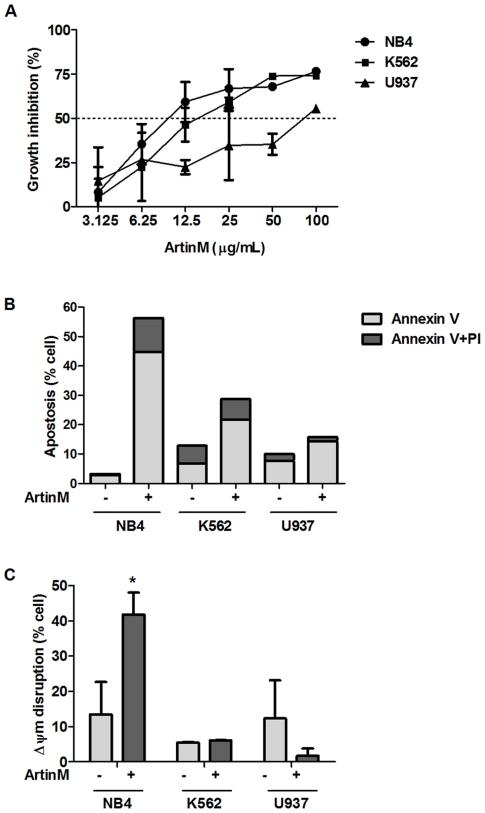
ArtinM inhibits cell growth inhibition and pro-apoptotic effect on NB4 cells.
A) NB4, K562, and U937 cells were cultured for 48 h in the presence or of ArtinM (3.125 to 100 µg/mL). Cell growth was evaluated by MTT assay. The curves show the ArtinM inhibition of cell growth relative to the growth of untreated cells. Each point was obtained from a triplicate assay, and the results shown are representative of 3 independent experiments. The dotted horizontal line indicates the ArtinM concentration necessary for 50% growth inhibition (IC50). B) NB4, K562, and U937 cells were cultured for 48 h in the presence or absence of ArtinM (10 µg/mL, IC50 for NB4). Cells were stained with FITC-Annexin V and propidium iodide (PI) to characterize apoptosis and to distinguish it from necrosis. Bars represent the proportion of Annexin V and Annexin V/PI-stained cells. Results represent 3 different experiments. C) Disruption of mitochondrial membrane potential (mΔΨ) of ArtinM-treated cells was assessed by flow cytometry after staining with JC-1.The bars represent the percentage of cells with mΔΨ disruption. The result shown are representative of 3 independent experiments and are expressed as mean ± SD, * p<0.05 (Tukey's test).